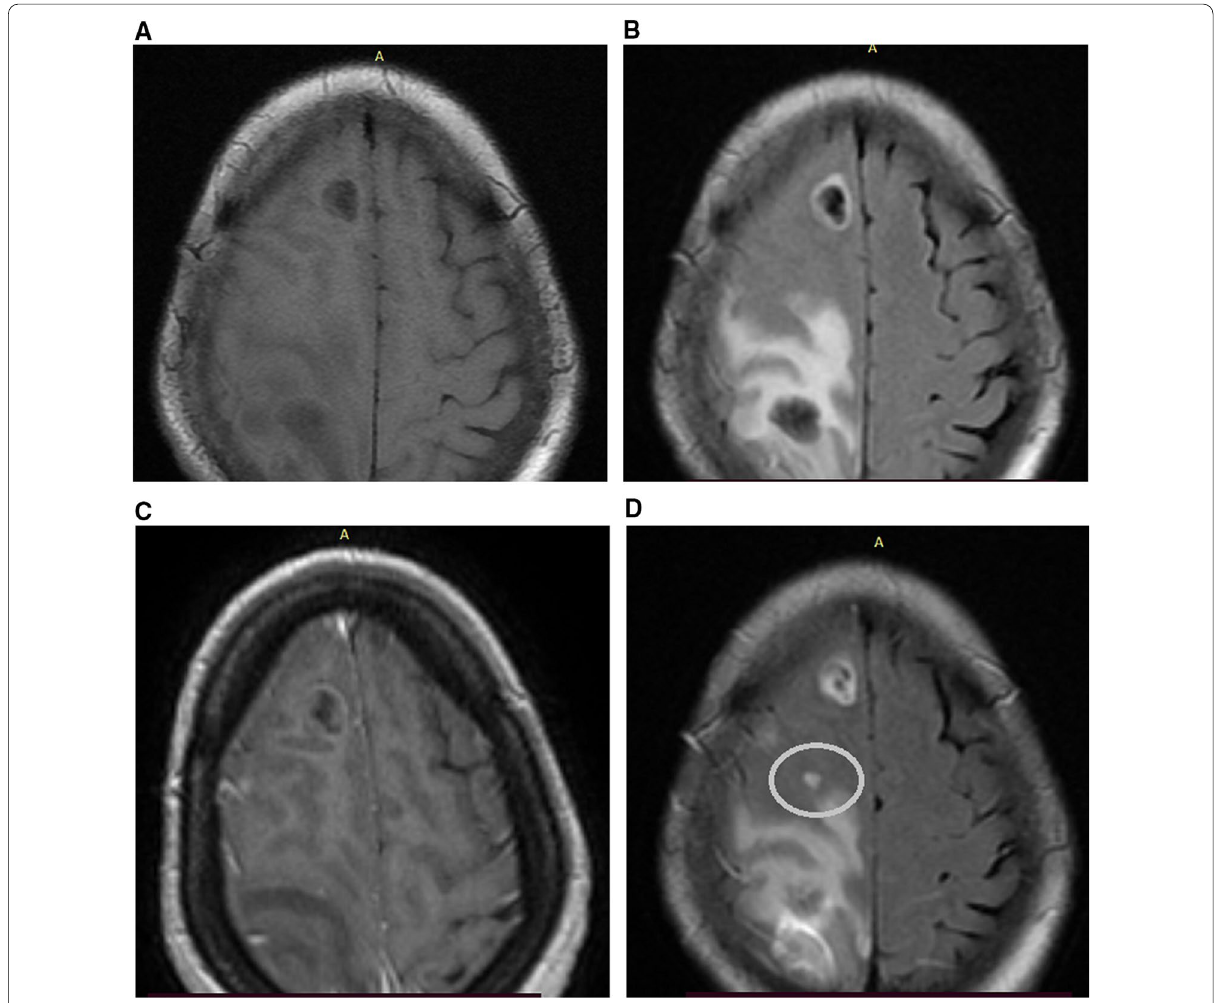
Fig. 2 A 58-year-old female patient with known breast cancer. MRI of the brain shows tiny cortical enhancing nodule, seen at the right frontal region only at DPC-FLAIR (D), but not detected at CE-T1WI (C). A Axial pre-contrast T1WI. B Axial FLAIR. C Axial CE-T1WI. D Axial